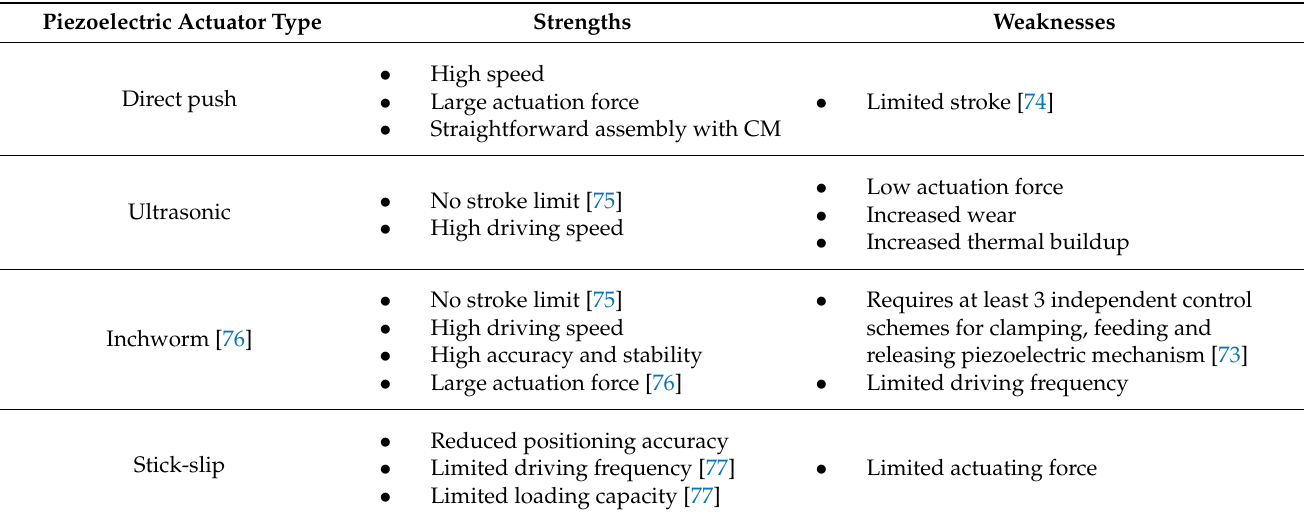
Table 1. Comparisons of various piezoelectric actuator